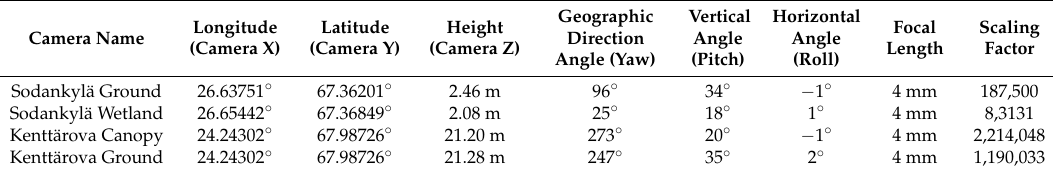
Table 1. Orthorectification parameters for the cameras.